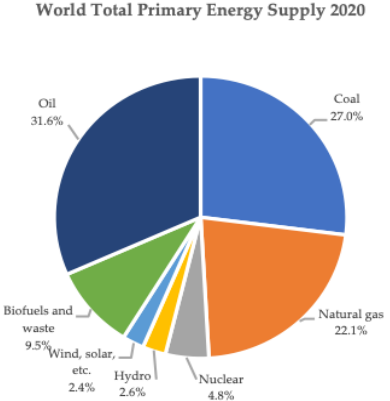
Figure 2. World Total Primary Energy Supply 2020 (authors’ forecasts).